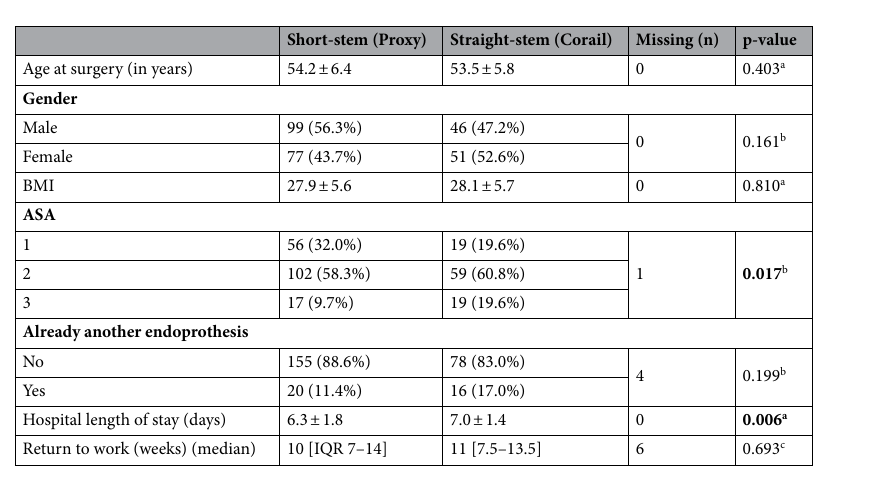
Table 1. Patient characteristics of both groups and median delay in RTW following THA. Bold values indicates statistical significance at the p < 0.05 level. IQR interquartile range. a t-test. b Chi-squared test. c